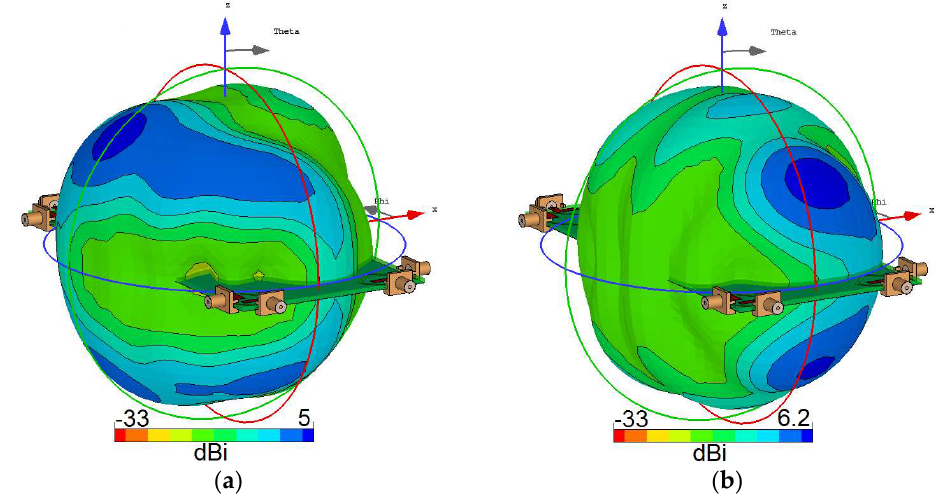
Figure 11. 3D transparent views of the radiation patterns for ( a ) feeding port 1 and ( b ) feeding port 2.